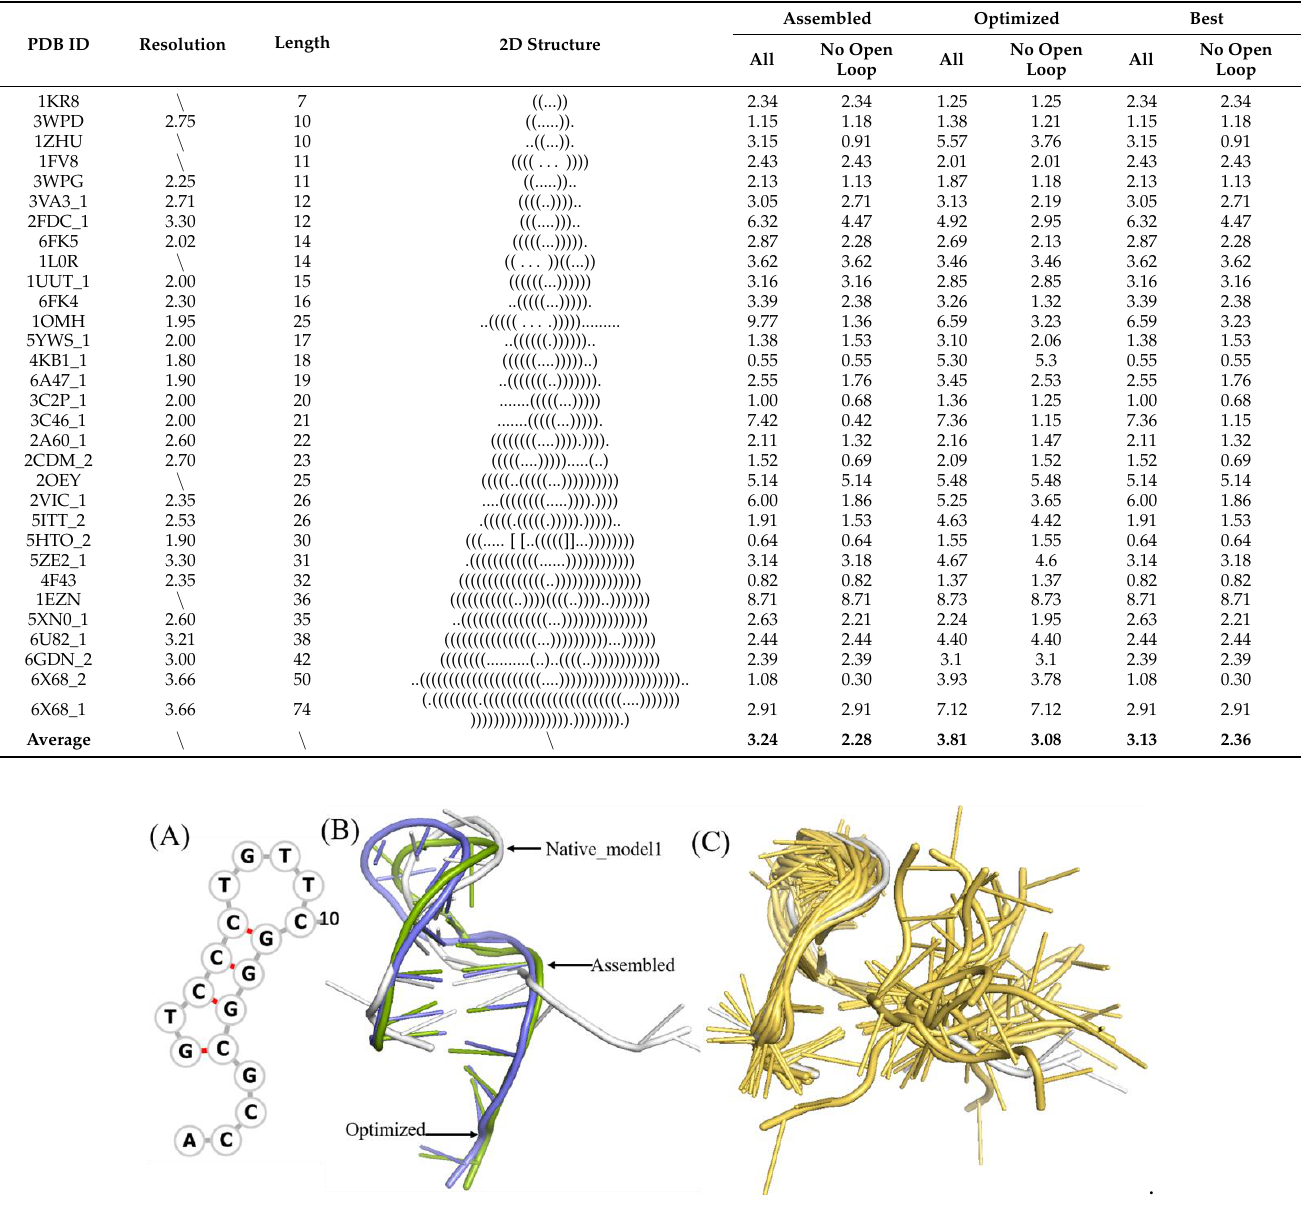
Figure 3. Two example of predicted 3D structures by 3dDNA. ( A ) The 2D and 3D structures of DNA 4KB1_1 with perfect template; the RMSD of assembled (green) and optimized (blue) structures with a native one (grey) are 0.56 Å and 5.3 Å , respectively. ( B ) The 2D and predicted 3D structures of DNA 1OMH with imperfect template, the RMSD of assembled (green) and optimized (blue) struc- tures with a native one (white) are 9.8 Å and 6.5 Å , respectively. 2.2. Prediction Accuracy of DNAs with Double Chains The DNAs with a single chain are only a small part of DNAs, 87% of which have two chains. A total of 56 DNAs were selected as Test Set 2 according to their length and 2D structure complexity. The detailed information of DNAs of this test set is given in Table 2. The mean RMSD value of the assembled, optimized structure, and best structures are 3.0 Å , 5.64 Å , and 2.83 Å , respectively (Figure 4 and Table 2). Overall, 3dDNA can reach